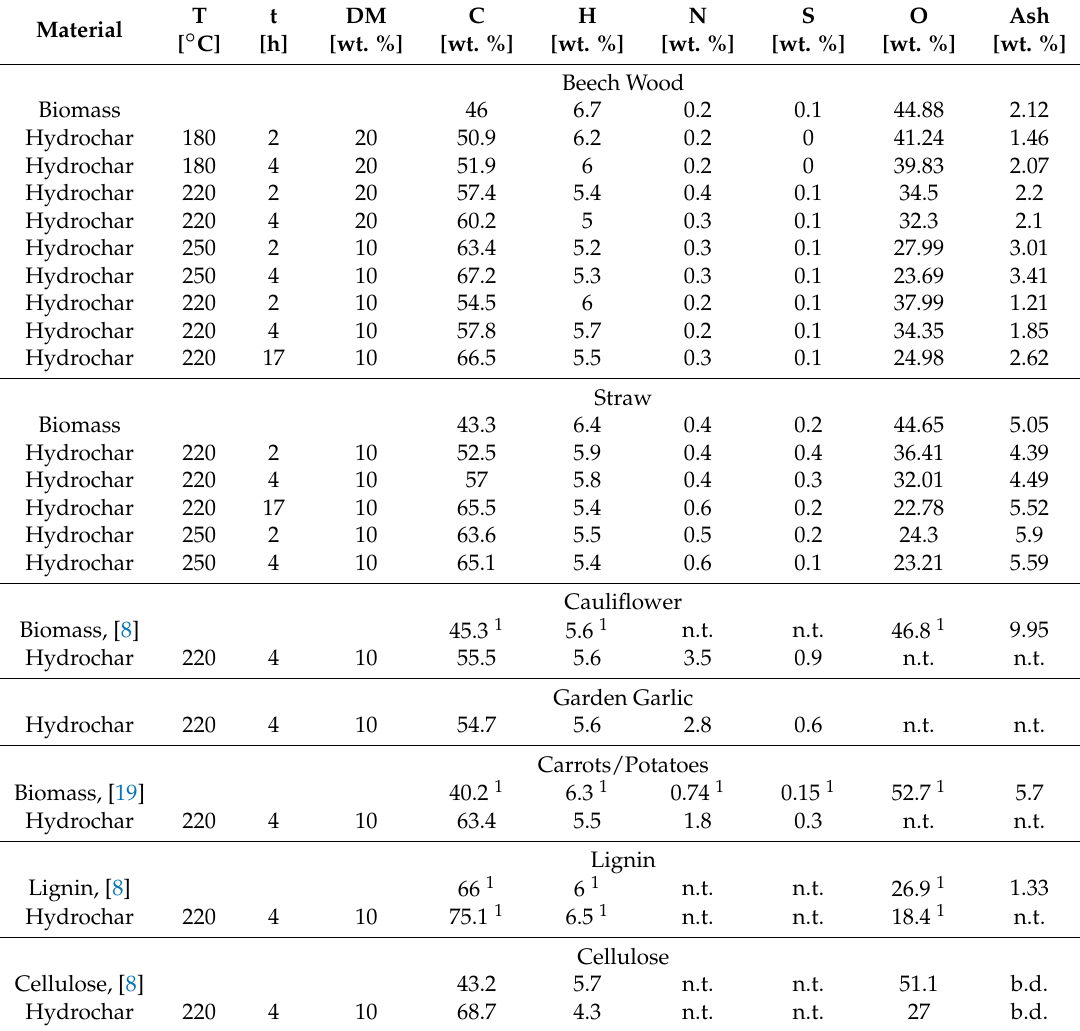
Table 1. Elementary composition of the biomass and the hydrochar formed. (All data measured a relative error of around 10%, for literature data see